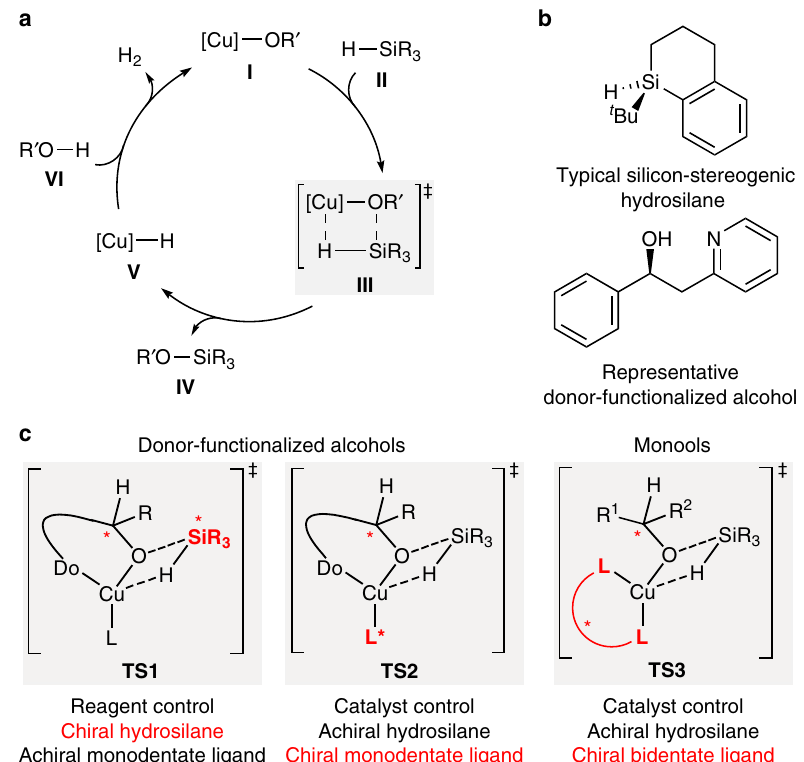
Figure 2 | Catalytic asymmetric Si–O coupling for kinetic resolution of alcohols. ( a ) Catalytic cycle of Cu–H catalysis. ( b ) Silicon-stereogenic hydrosilane and typical donor-functionalized substrate. ( c ) Enantioselectivity-determining transition states in the various approaches.